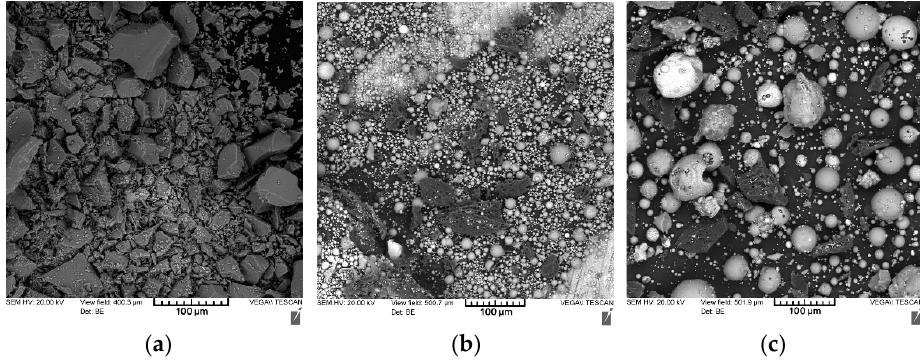
Figure 4. Microstructures of the studied coal energy wastes: ( a ) fuel slag; ( b ) fly ash; ( c ) ASM. The microstructure of the milled fuel slag (a) is represented by particles of an irregular shape with a size of 10–100 µm. The particles are represented by an amorphous material with a smooth vitrified surface. The microstructure of fly ash (b) is mainly represented by hollow aluminosilicate microspheres with a size of 1–50 µm.